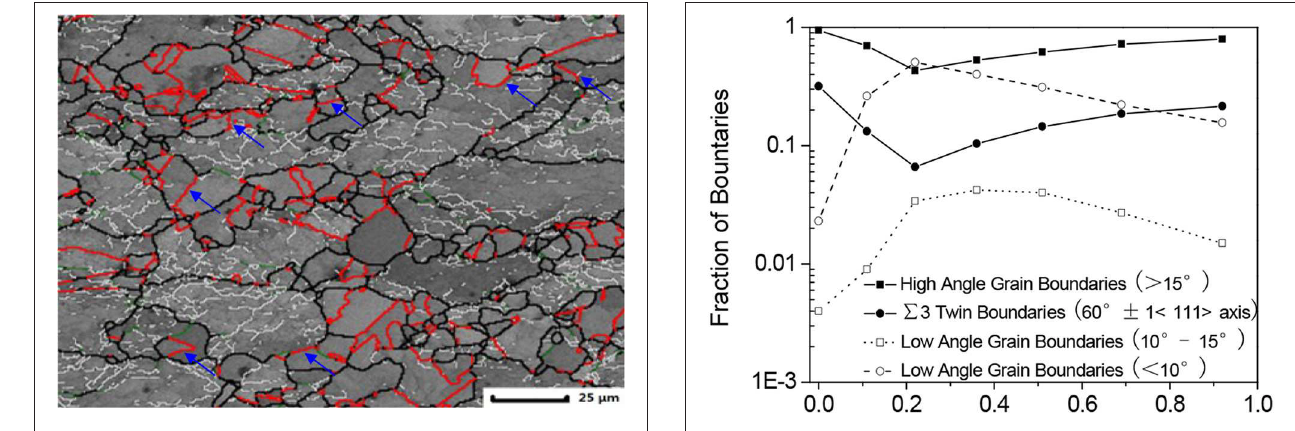
FIGURE 11 | Separation of twin boundary from parent grains. The high, low angle and 6 3 twin boundaries are shown as black, white and red lines, respectively. FIGURE 12 | The variation of fraction for different kinds of boundaries vs.